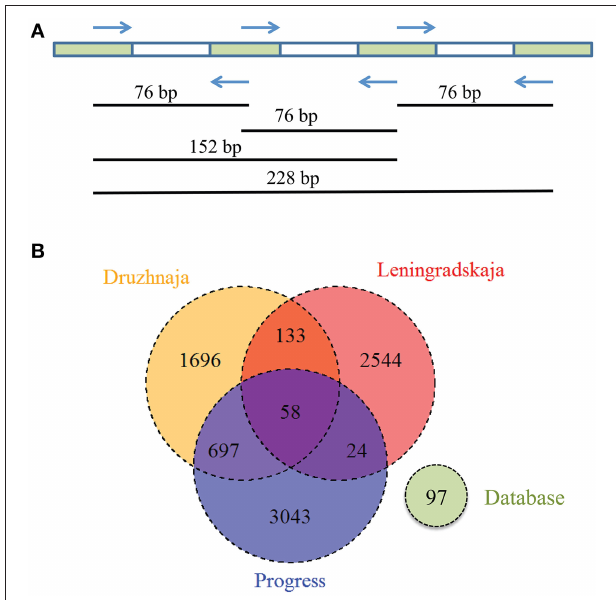
FIGURE 5 | Analysis of Flavobacterium physchrophilum CRISPR spacers in Antarctic snow samples. (A) A strategy used to amplify spacers associated with F. physchrophilum CRISPR repeats from environmental samples, the length of amplified fragment corresponds to the number of containing spacers. (B) A Venn diagram showing the number of shared and unique clusters of spacers associated with F. physchrophilum CRISPR repeats in three Antarctic snow samples. Known F. physchrophilum spacer clusters from 10 publically available genomes are also shown